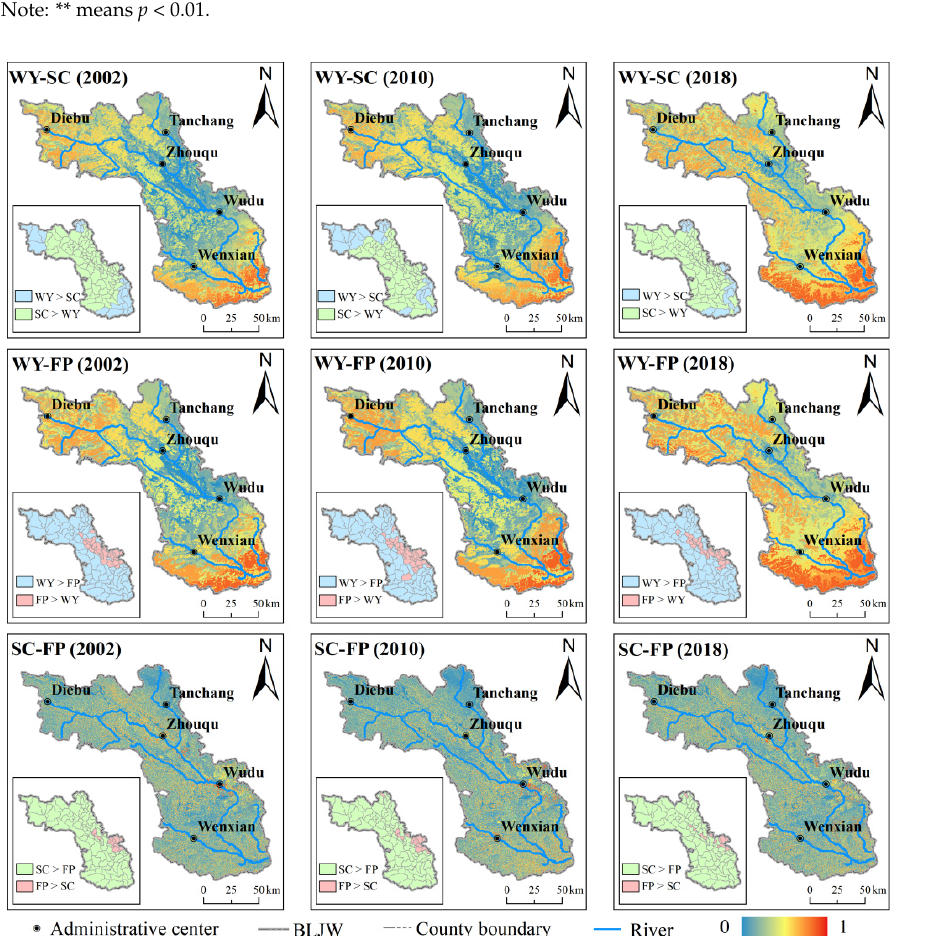
Figure 6. Map of the ESs trade-off intensity in the BLJW from 2002 to 2018. Table 2. Correlation coefficients between ES pairs in the BLJW in Gansu from 2002 to 2018.